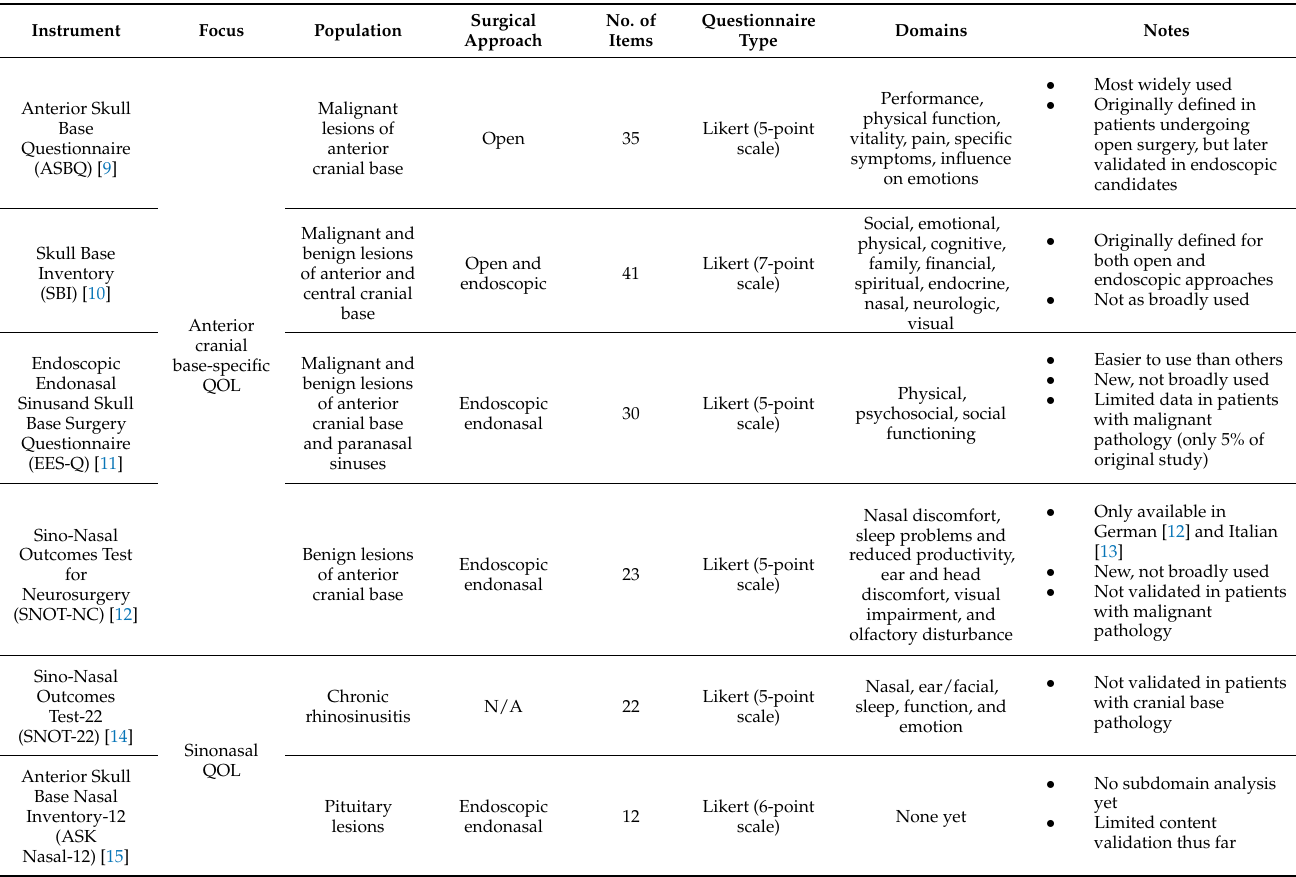
Table 1. Anterior cranial base and sinonasal-specific quality of life (QOL)